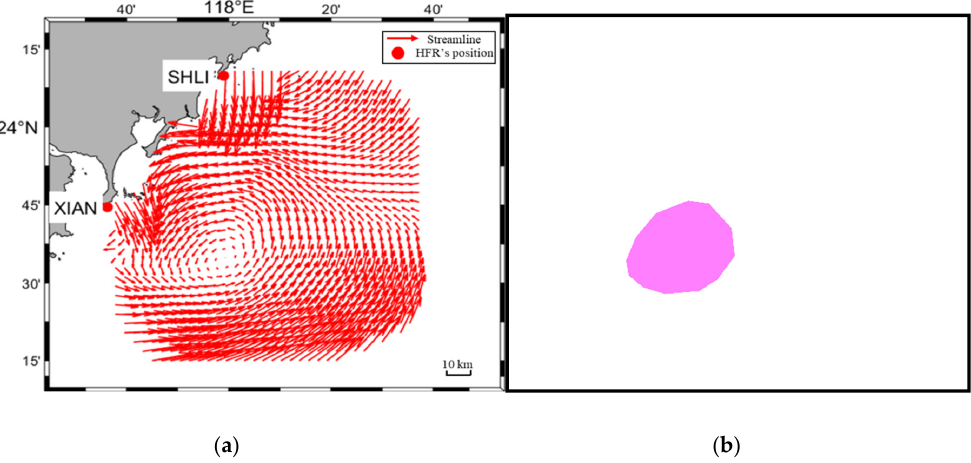
Figure 2. Example of pixel segmentation training couple. ( a ) Original flow chart; ( b ) Eddy segmentation mask results.